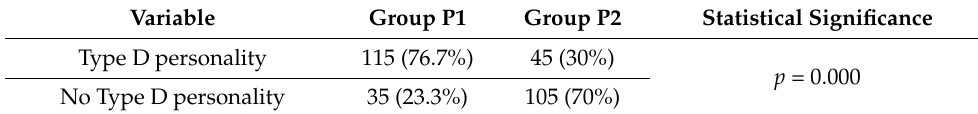
Table 1. The occurrence of type D personality in groups P1 and P2.